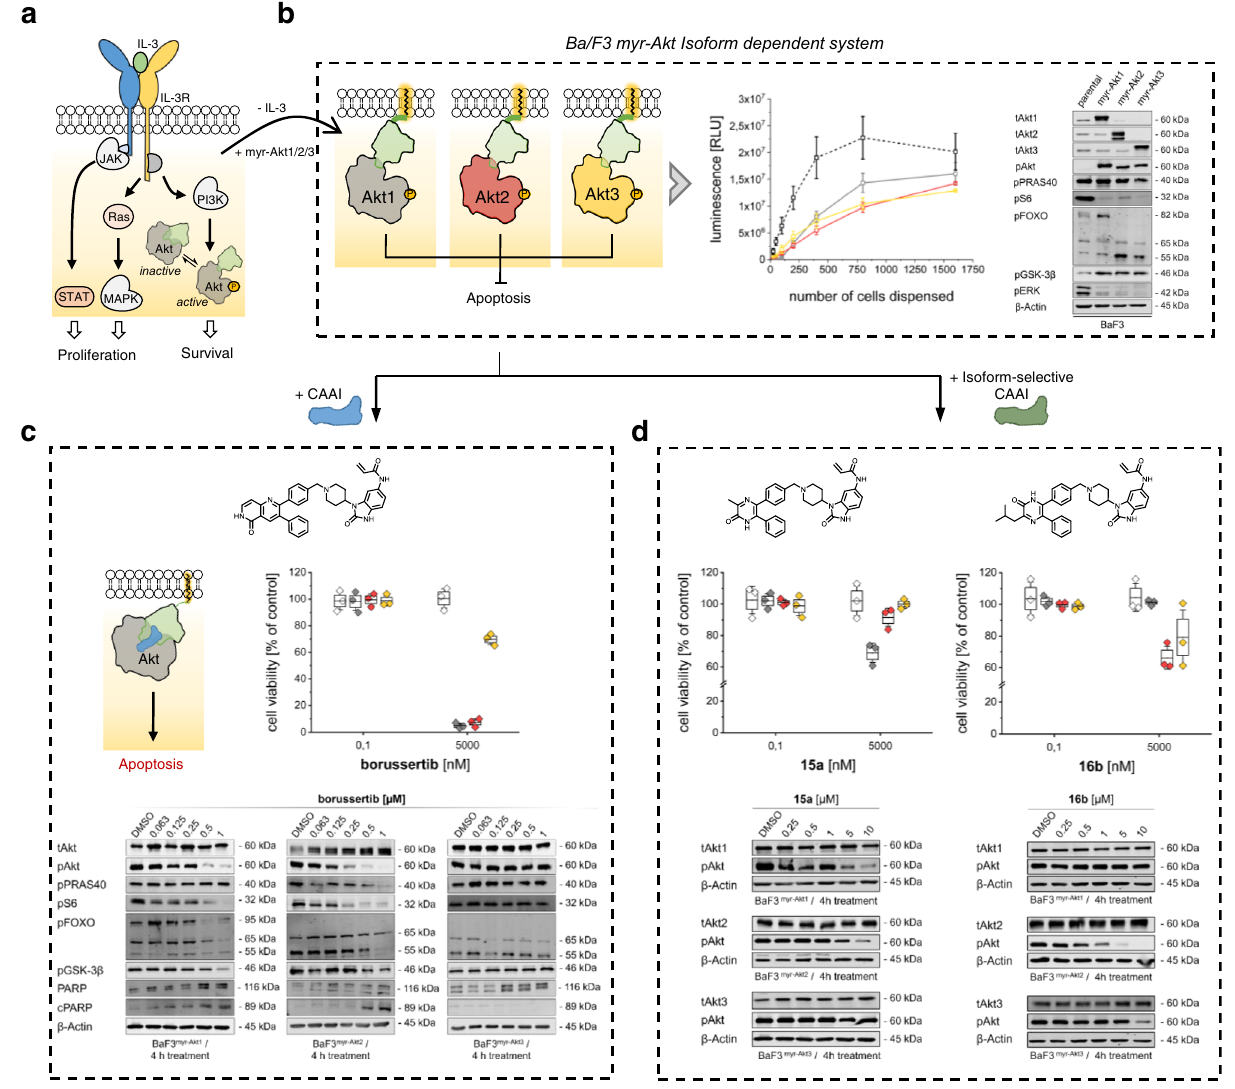
Fig. 1 Generating Ba/F3 myr-Akt isoform-dependent cell lines to evaluate targeted Akt inhibition. a Representation of the IL-3 signaling pathway in the murine Ba/F3 cell upon binding of IL-3. b General overview of the established cell lines Ba/F3 myr-Akt1 (gray), Ba/F3 myr-Akt2 (red), and Ba/F3 myr-Akt3 (yellow). Graph showing the seeded cell number of the Ba/F3 constructs and resulting luminescent signals following treatment with CTG solution compared to the parental system (dotted line, white). The experiments were performed in triplicates with n = 3. Error bars indicate s.d. Immunoblot of myr- Akt isoform systems highlighting the molecular expression levels, activities, and alterations of downstream targets of Akt ( n = 1 biologically independent experiment). c Addressing the Ba/F3 myr-Akt with CAAI borussertib to investigate the sensitivity of the established system. Structure of used inhibitor and schematic representation of the binding mode. Graph showing the remaining viable cells as a percentage with respect to the used concentration of borussertib. Experimental points were measured in duplicates for each plate and were replicated in n = 3 biologically independent experiments. Immunoblots resolved individual Akt isoforms ’ presence and activity within the three model systems after 4-h treatment ( n = 1 biologically independent experiment). d Addressing the Ba/F3 myr-Akt cells with isoform-selective CAAIs 15a / 16b to investigate selectivity translation into the established system. Graph showing the remaining viable cells as a percentage with respect to the used concentration of 15a and 16b . Experimental points were measured in duplicates for each plate and were replicated in n = 3 biologically independent experiments. Structure of used inhibitors. Immunoblots resolved isoform selective activity within the three model systems after 4-h treatment ( n = 1 biologically independent experiment). In c , d the box plot middle line represents the mean value, the box represents the fi rst and third quartile and the error bars indicate s.e. Source Data are provided with this